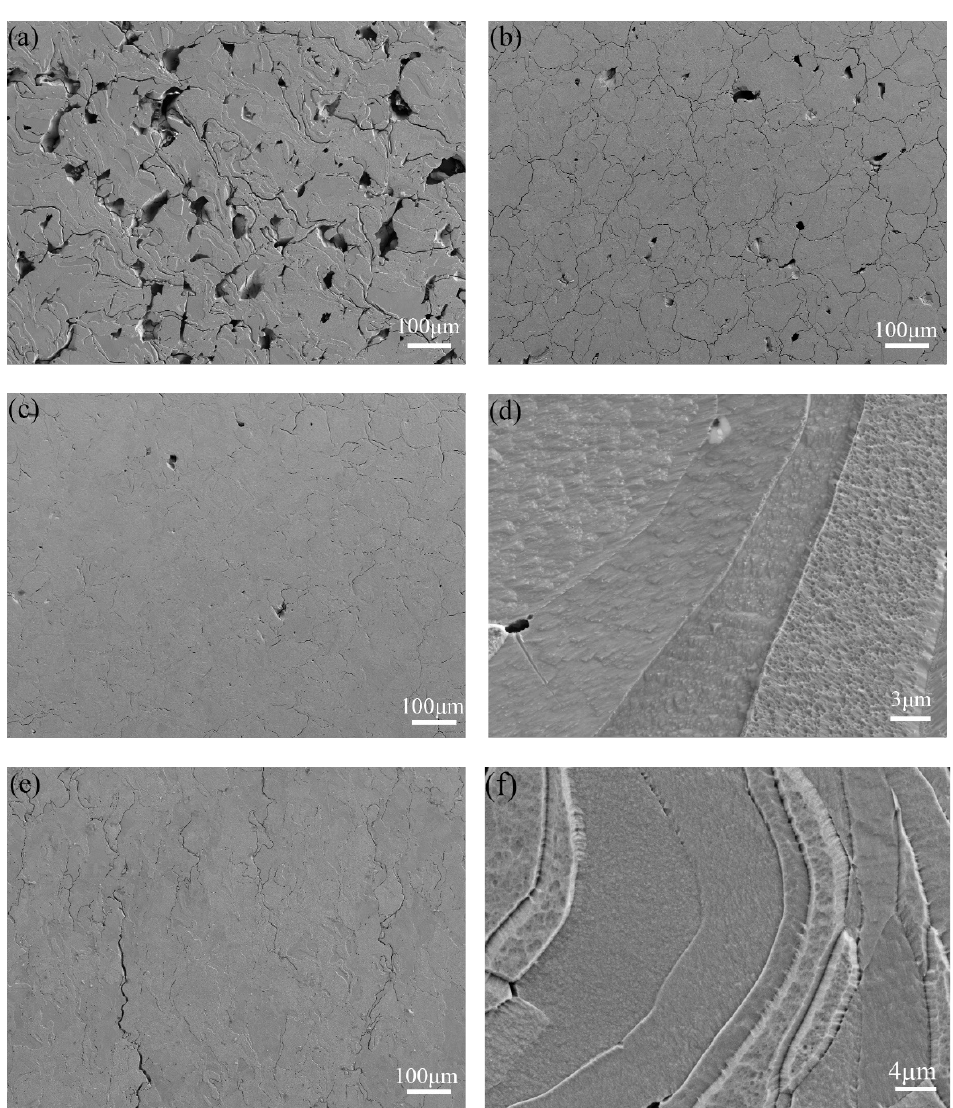
Figure 8. The SEM image of a-d top view and e-f side view cross section of SLM Mo: ( a ) top view of LED = 0.36 J/mm, ( b ) top view of LED = 0.64 J/mm, ( c ) top view of LED = 0.51 J/mm, ( d ) high-magnification of ( c ), ( e ) side view of LED = 0.51 J/mm, ( f ) high-magnification of ( e ).